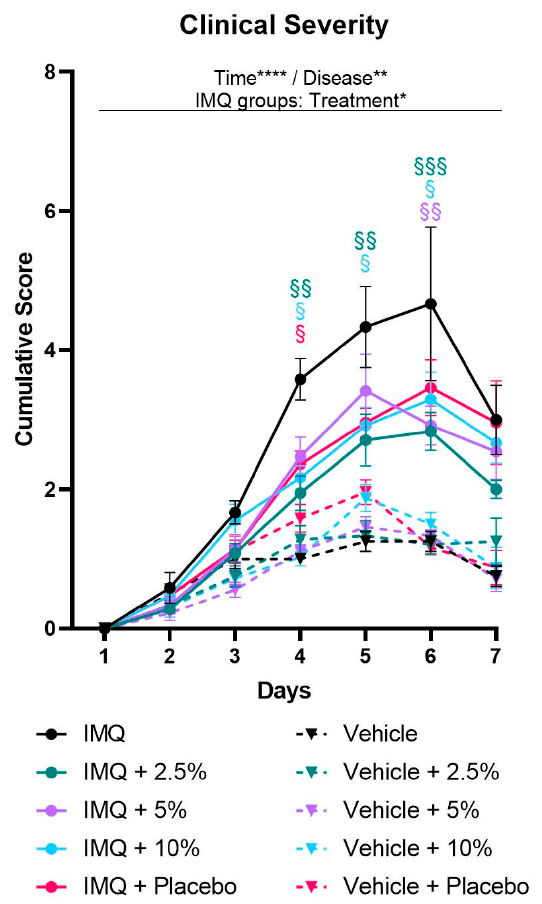
Figure 1. Diacerein ameliorates clinical severity of IMQ-induced psoriasis. Clinical severity is represented by the cumulative score calculated from daily semiquantitative score points for erythema, scaling, and thickening of the dorsal skin. Psoriasis was induced by daily topical application of 62.5 mg Aldara ® (IMQ) to the dorsal skin. Following IMQ, mice were treated with 100 mg of 2.5%, 5%, or 10% diacerein or placebo or the skin was left untreated. Control mice received vehicle cream. Data represent means ± SEM. n = 3–9 per group. Three independent experiments. * p < 0.05, ** p < 0.01, **** p < 0.0001, repeated measures two-way ANOVA main effects. § p < 0.05, §§ p < 0.01, §§§ p < 0.001 vs. untreated IMQ, Tukey’s multiple comparison test.